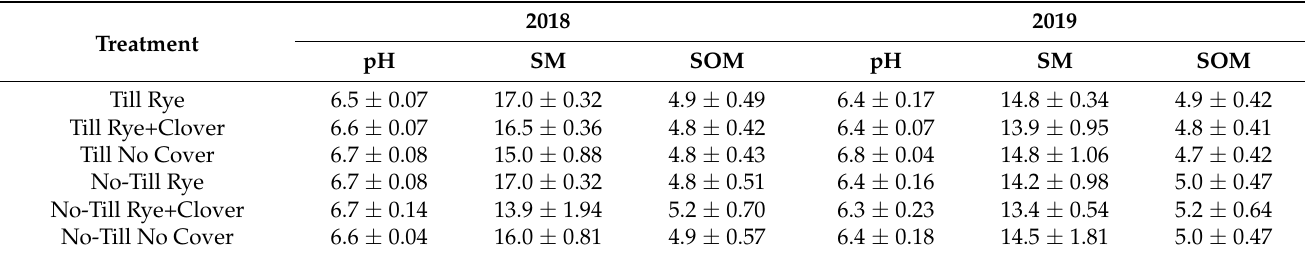
Table 1. Soil chemical traits in 5–15 cm soil in spring 2018 and 2019 *.